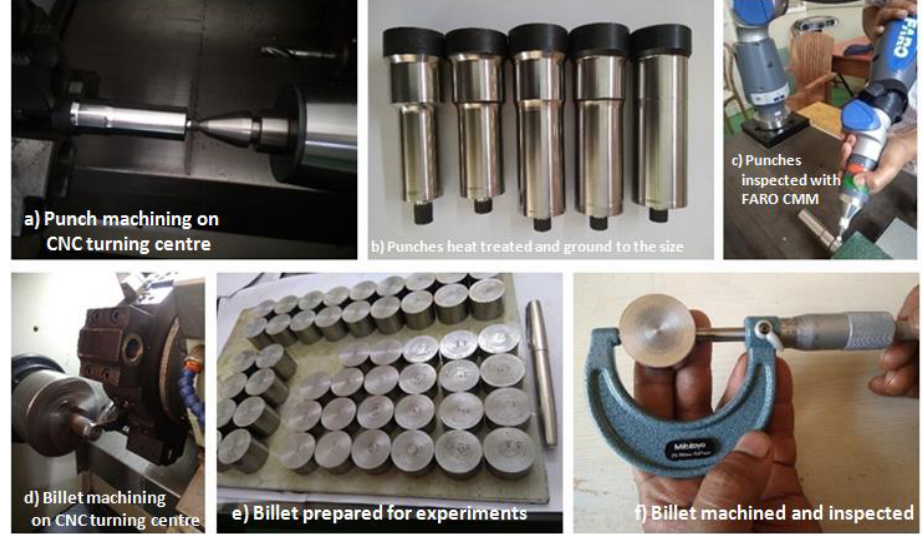
Figure 5. Punches and billets preparation (Courtesy: KLE Technological University, Hubballi, India).